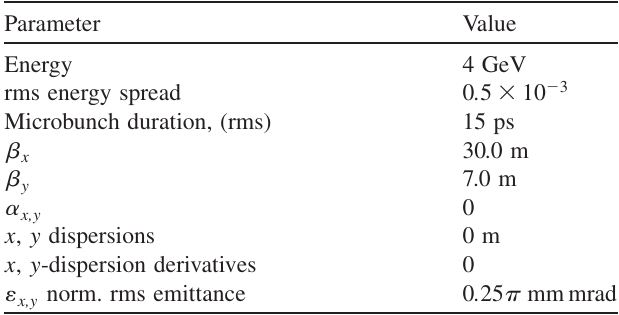
TABLE III. Parameters of the beam for the PS2.